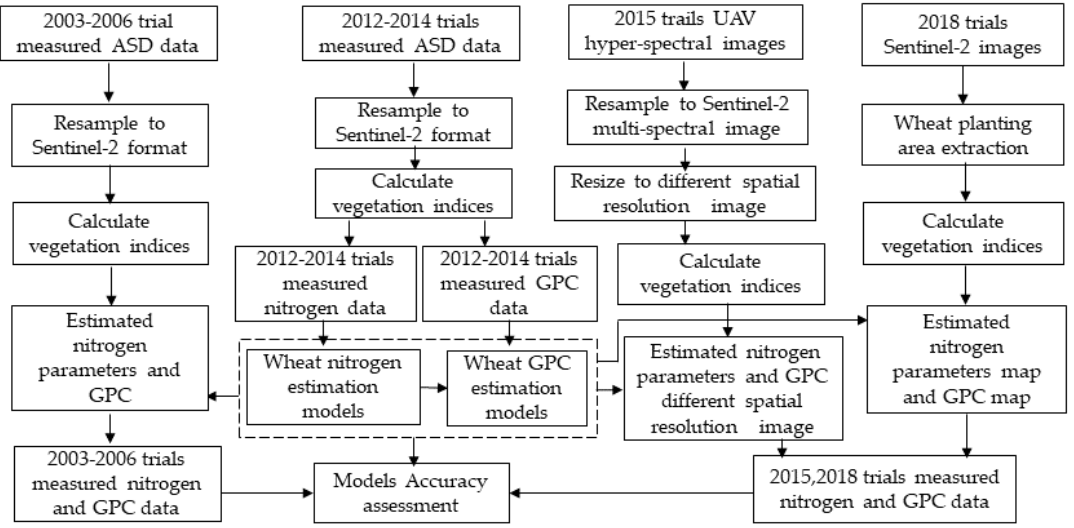
Figure 4. Workflow of the Figure 4. workflow of the study. Figure 4. workflow of the study.